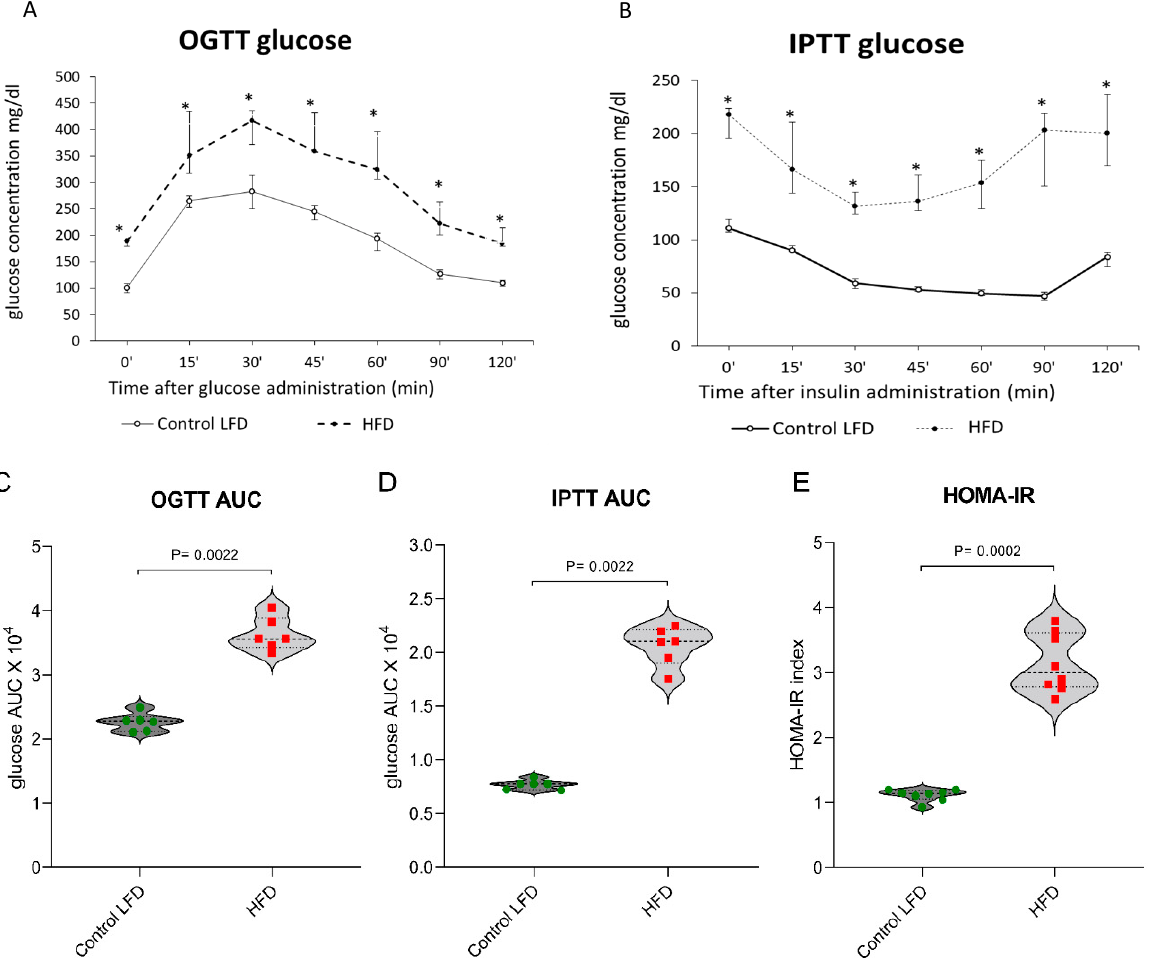
Figure 6. ( A – E ) The impact of high-fat diet consumption on plasma glucose concentration: ( A ) plasma glucose profile during the oral glucose tolerance test (OGTT); ( B ) plasma glucose profile during the intraperitoneal insulin tolerance test (IPTT); ( C ) area under the plasma glucose curve for OGTT (IPTT); ( D ) area under the plasma glucose curve for IPTT; ( E ) HOMA-IR value. Significance by Mann–Whitney U test. The figures show the median and interquartile range ( n = 6 per group). Green circles—values for individual Control LTD gastrocnemius muscles; Red squares—values for individual HFD +scrshRNA gastrocnemius muscles. * p <